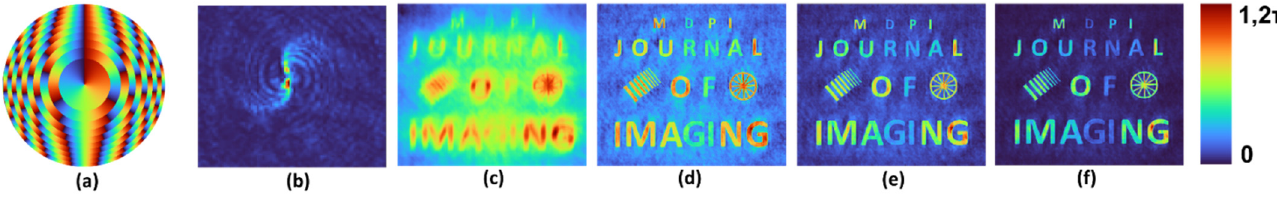
15 of 18 Figure 15. ( a ) Optical microscope image of the randomly multiplexed bifocal diffractive lenses. ( b ) Recorded PSF, ( c ) object’s response pattern. Reconstruction results using ( d ) NLR ( p = 1), ( e ) NLR ( p = 2) and ( f ) NLR ( p = 3) for FINCH with spatial random multiplexing configuration. 4.11. Double-Helix Beam with Rotating PSF